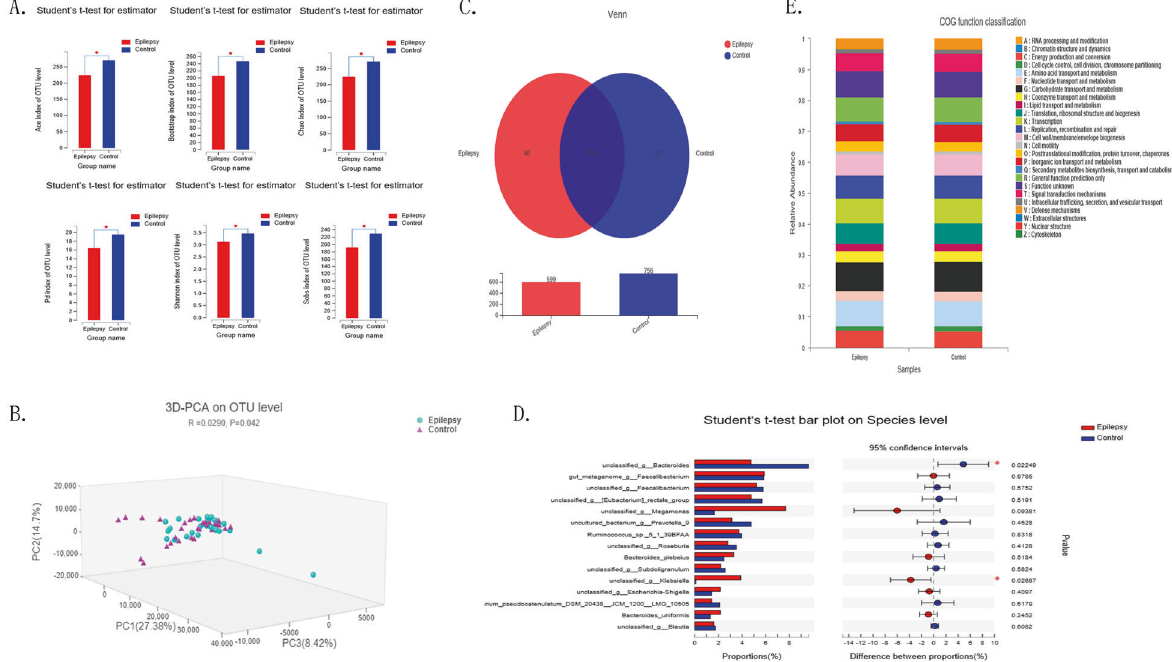
Fig. 1 16s rRNA sequencing in the epilepsy and healthy groups. A Alpha diversity index (including ace, sobs, chao, bootstrap, pd, Shannon) showing a signi fi cant difference between the epilepsy group and healthy group ( n = 30 in each group; * P < 0.05 epilepsy versus controls, Student ’ s t test). B Principal coordinate analysis (PCoA) of the sample was calculated using the Adnois algorithm, and the epilepsy group was signi fi cantly different from healthy population ( n = 30 in each group; * P < 0.05 epilepsy versus controls). C The Venn diagram based on the OTU level shows that the epilepsy group had 40 speci fi c OTUs. D Bacteroides and Klebsiella were signi fi cantly different between the epilepsy and control groups at the species level ( n = 30 in each group; * P < 0.05 epilepsy versus controls, Student ’ s t test). E Bar chart depicting the gene ontology classi fi cation in epilepsy and control groups ( n = 30 in each